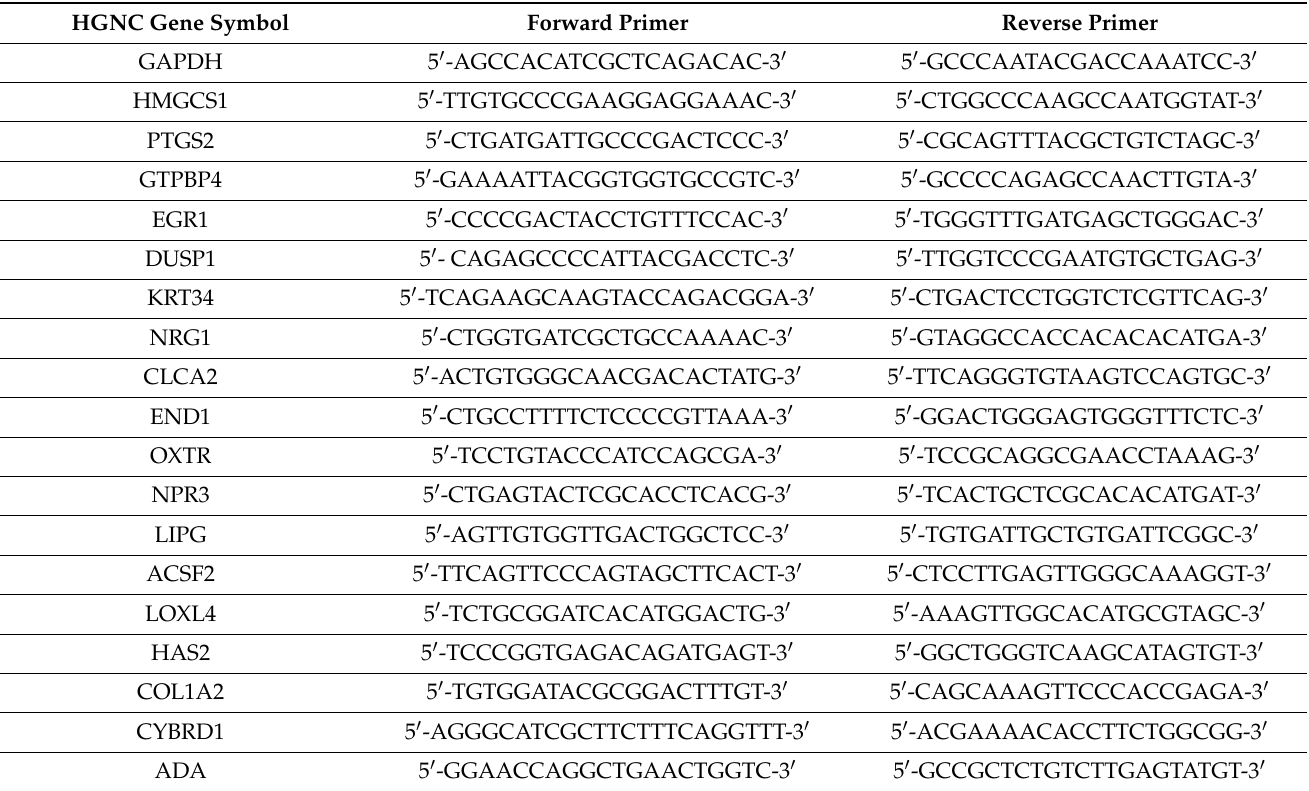
Table 1. Primers for